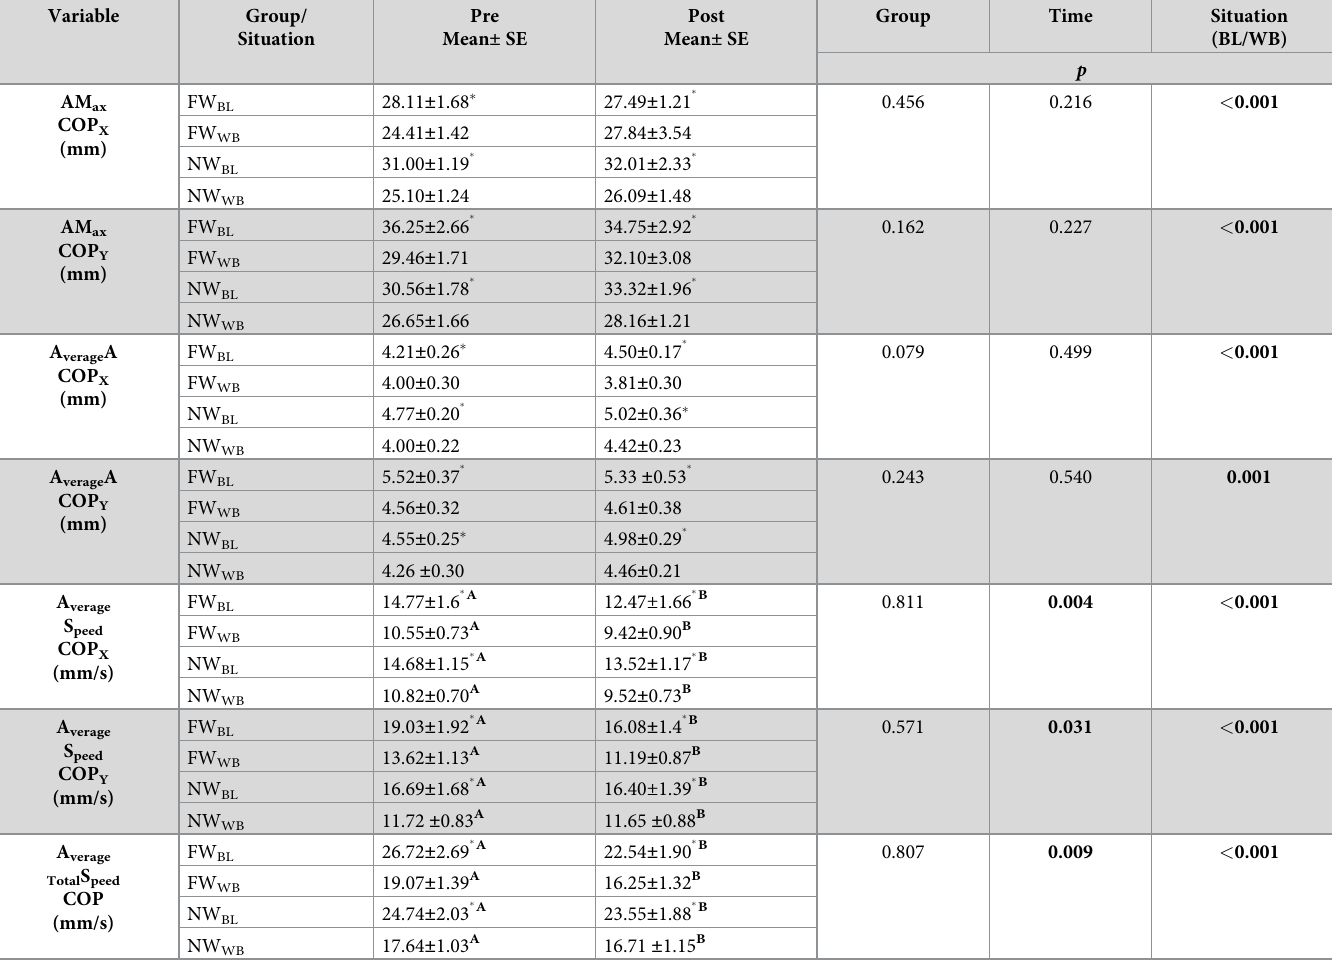
Table 3. Mean, SE, and differences from GEE model effects tests for static balance variables in force platform. � symbol represents differences between with the closed and open eyes situations in inter-group relation (within each group). Different capital letters represent significant differences of time factor (pre and